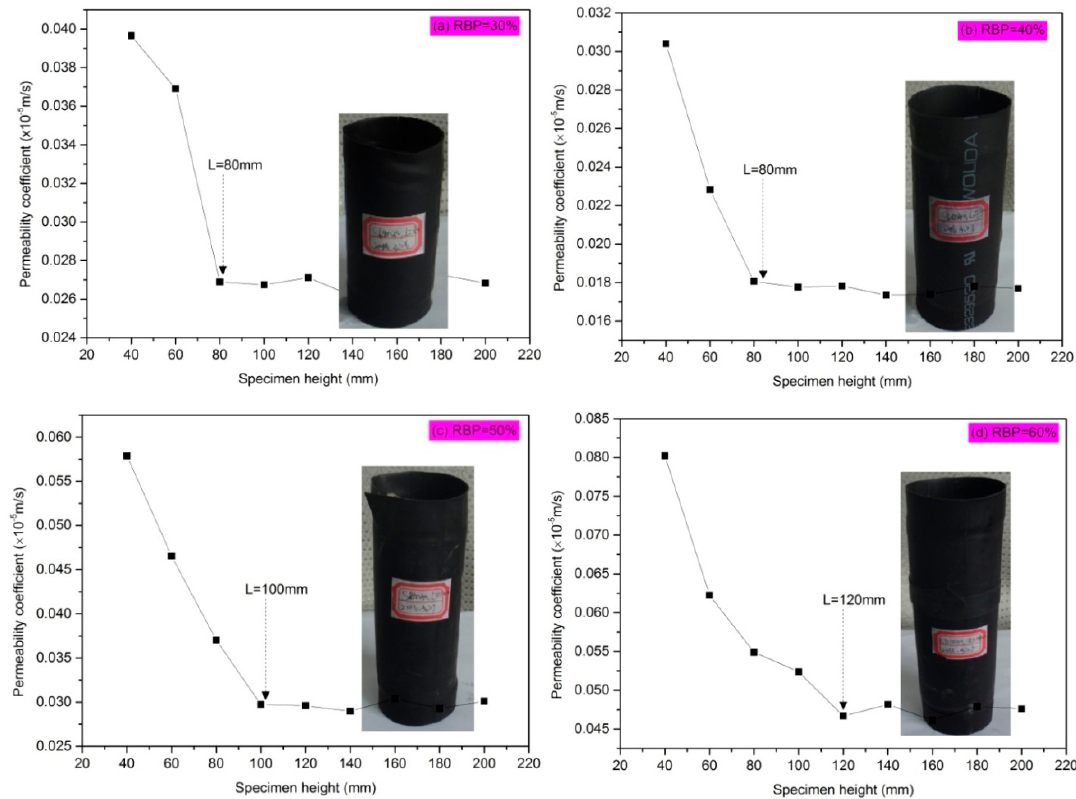
Figure 10. The plots of permeability coefficient against sample height for typical bimsoil samples:( a – d ) the RBP is 30%, 40%, 50%, and 60%, respectively.